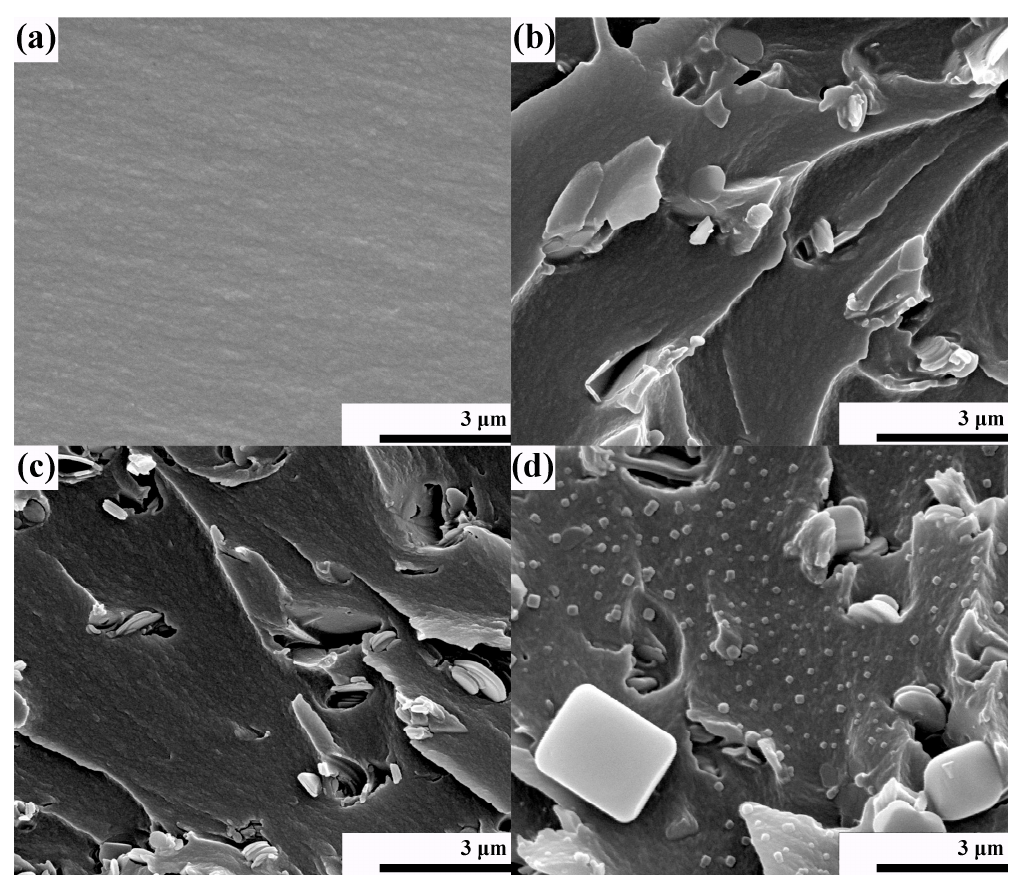
Figure 4. SEM images of PEN-g-BN0 ( a ), PEN-g-BN8 ( b ), PEN-g-BN16 ( c ), and BN/PEN with 8 wt % of BN ( d , reprinted with permission from [32]).